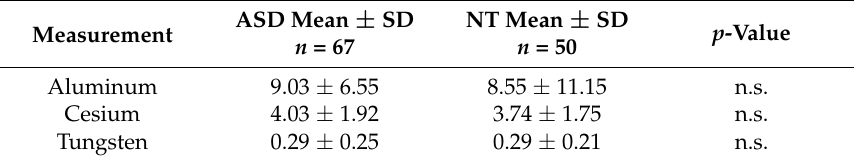
Table 2. Means and standard deviations of levels of three urine toxic metals in the ASD and NT cohorts from the Comprehensive Nutritional and Dietary Intervention Study. Metal levels are in units of µ g/g of creatinine. Reported p -values were obtained from the two-tailed Welch’s t -test.